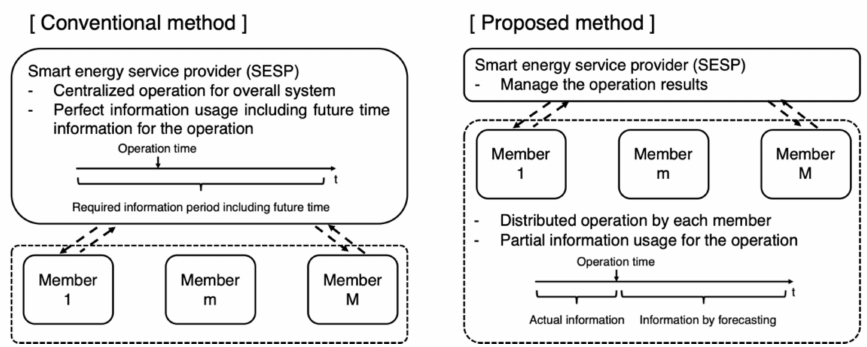
Figure 1. Conceptual comparison between the conventional method and the proposed